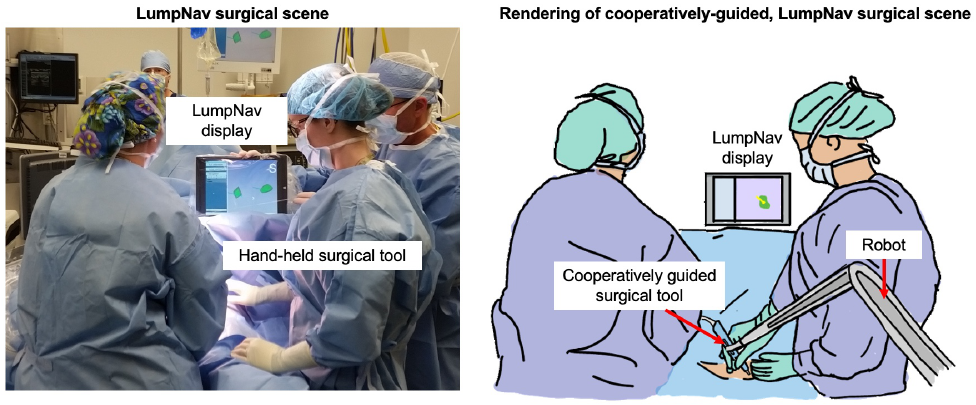
Figure 9. ( Left ) Surgical scene from LumpNav case with no cooperative robotic guidance. ( Right ) Rendering of the surgical scene with LumpNav and cooperative robotic